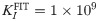
Model for iron uptake including IRT1 and FIT.(a) Reaction scheme of the model. See S3 Text for rate equations. (b) Overview over the feedback structure of the model at the protein and cytosolic iron levels. The inhibition outlined in blue defines an additional auxiliary negative feedback which does not influence the set-point of cytosolic iron, but accelerates the adaptation kinetics of the controller (see (d)). (c) Regulation of IRT1- and FIT-mRNA and protein levels and response kinetics of the iron uptake system at low (-Fe) and high (+Fe) external iron concentrations and in the absence of the auxiliary feedback (KIFIT=1×109). The lower part of the panel shows the IRT1- and FIT-mRNA and protein levels in a blot-like representation, where high levels under -Fe conditions have a gray scale of 100%, while +Fe levels have a reduced gray scale in relation to their reduced numerical values. (d) Same as in (c), but now in the presence of the auxiliary feedback (KIFIT=1×10-1). Note the improvement in the adaptation kinetics of the system. Rate constants for (c) and (d): k1 = 1.0, k2 = 2.0, k3 = 1 × 102, k4 = 1.0, k6 = 4 × 102, k8 = 1 × 102, KIFIT=1×109, k11 = 1 × 103, k12 = 1 × 103, KaFIT·TF=1×104, k18 = 1 × 102, k19 = 1 × 101, k20 = 1 × 104, k21 = 2 × 104, KIFe=1.0, k25 = 4.0, VmaxFIT=2.0, KMFIT=1×10-4. Initial concentrations for (c): Fecyt0 = 1.0, IRT10 = 4.0, IRT10=16.0, FIT0 = 381.0, TF0 = 0.5, FIT⋅TF0 = 1905.0, FIT0=381.0. Initial concentrations for (d): Fecyt0 = 1.0, IRT10 = 4.0, IRT10=0.3, FIT0 = 5.6, TF0 = 0.5, FIT⋅TF0 = 28.0, FIT0=5.6. (e) Experimental results of IRT1 and FIT mRNA and protein levels in wild-type Arabidopsis roots under iron sufficient (“+Fe”) and iron deficient (“-Fe”) conditions. The IRT1-protein and mRNA results as well as the FIT-mRNA blot are reproduced with permission from Fig 1 of Ref. [12]. The FIT-protein Western blot is reproduced with permission from Fig 4A of Ref. [47].